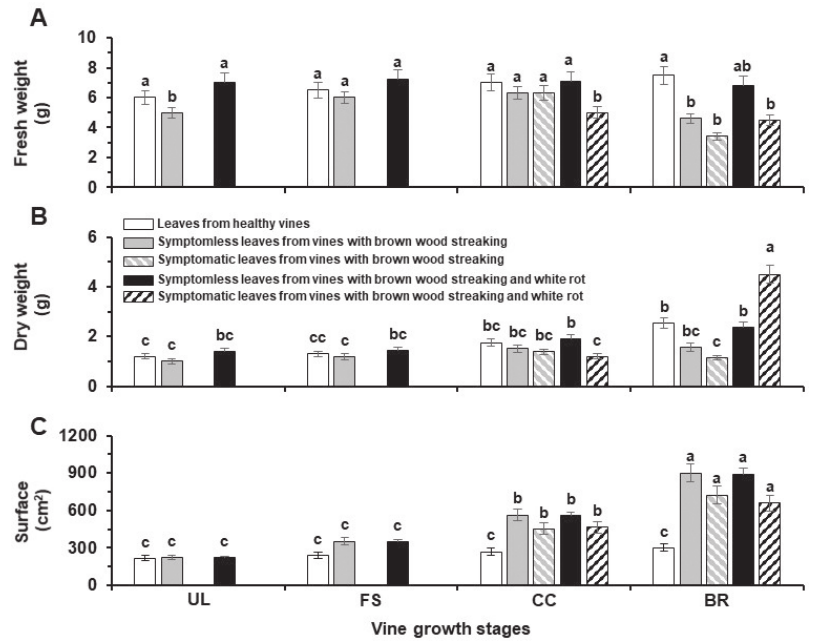
Figure 2. Fresh (A) and dry (B) weights, and surface areas (C) of ‘Italia’ leaves collected during the unfolded leaf (UL), fruit set (FS), clus- ter closing (CC) and bunch ripening (BR) vine growth stages from infected or healthy vines. Data are the means of 50 replicates ± stand- ard deviations. For each parameter, values accompanied by the same letters are not significantly different ( P ≤ 0.05) according to Fisher’s LSD test.